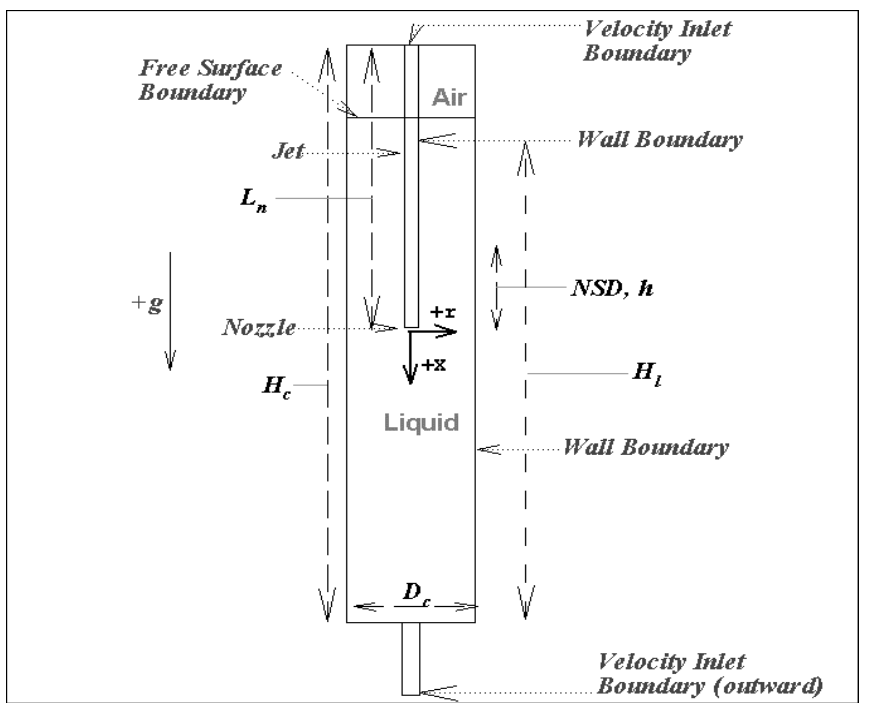
Figure 1: A schematic diagram of the computational domain of the submerged liquid jet apparatus with the boundary d =9.6 mm, conditions [ in